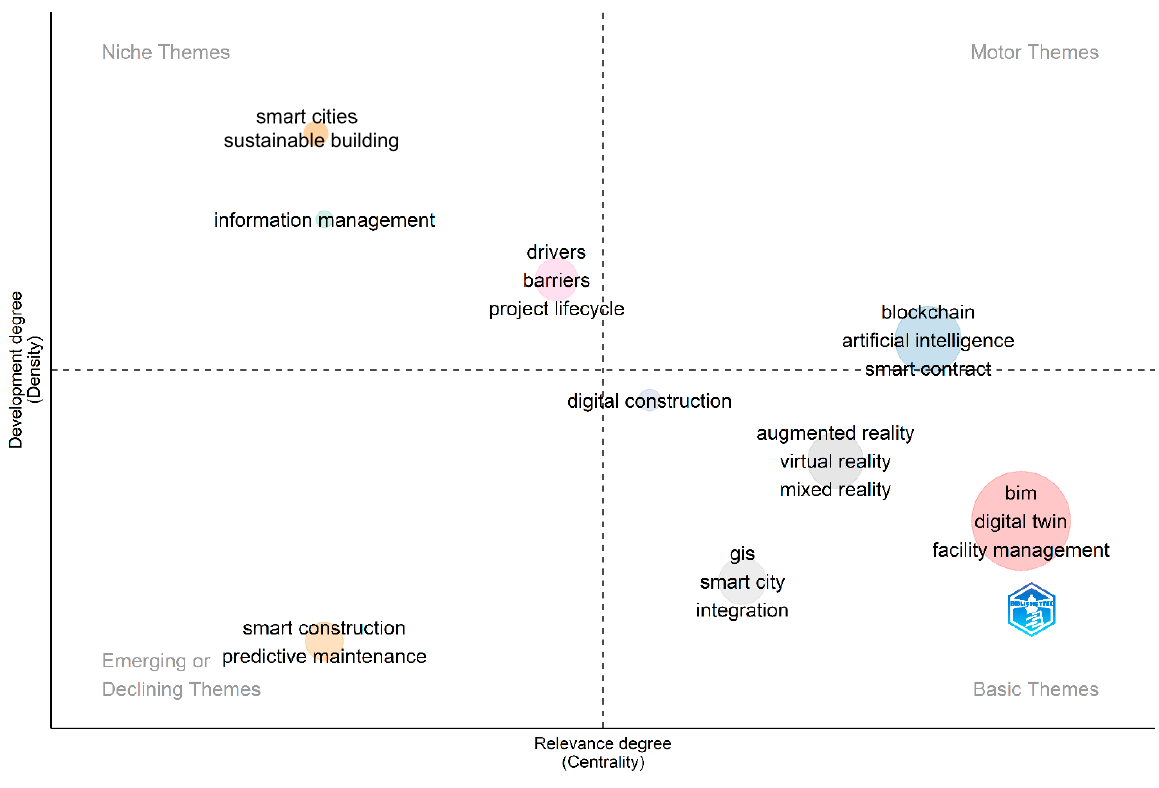
Figure 14. Thematic map analysis performed with Biblioshiny version 4.0.